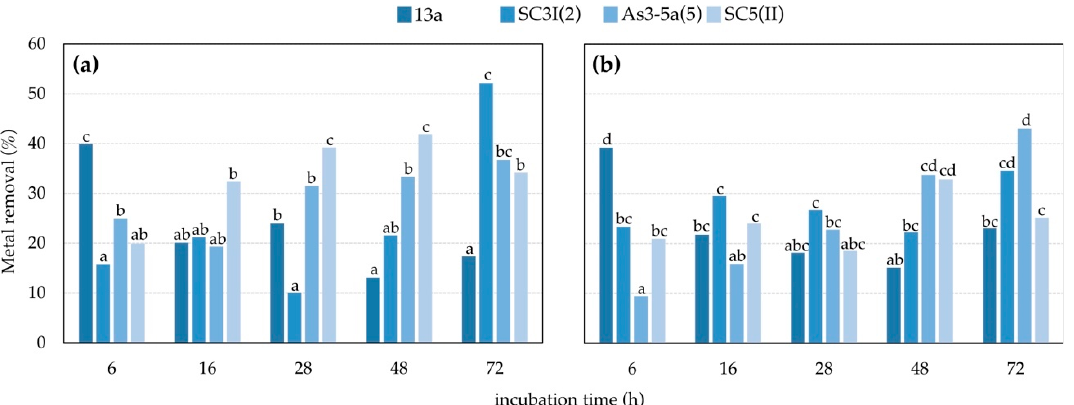
Figure 1. Effect of incubation time on biosorption of Ni 2+ (a) and Cu 2+ (b) by different strains in the biofilm-based system. Letters indicate whether the values differ significantly according to Tukey’s test ( p < 0.05).